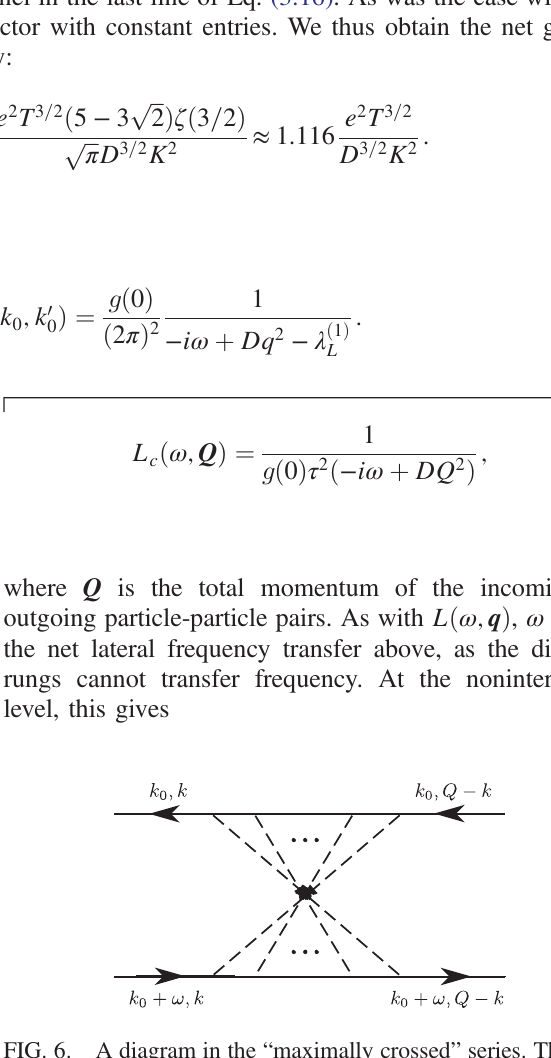
FIG. 6. A diagram in the “ maximally crossed ” series. The sum ω ; Q Þ as discussed in the main of this series gives L c ð